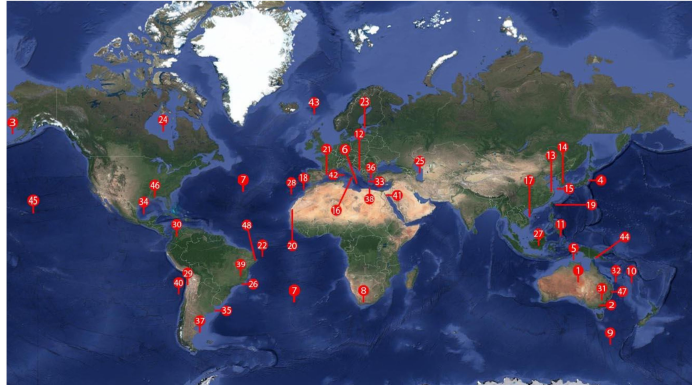
Figure 3. World map with geographical location of the parasites of the Anisakidae family, collected from di ff erent